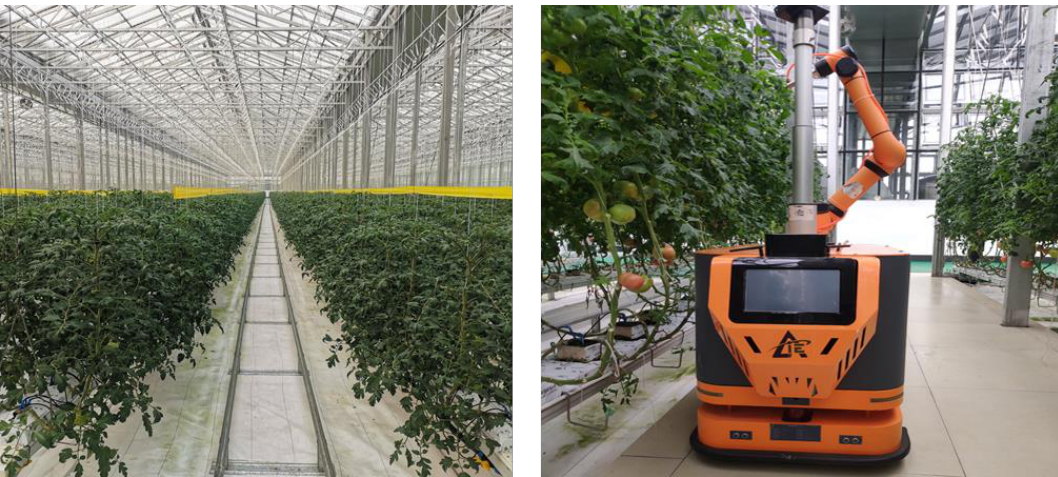
Figure 1. Experimental site and tomato pollination robot.